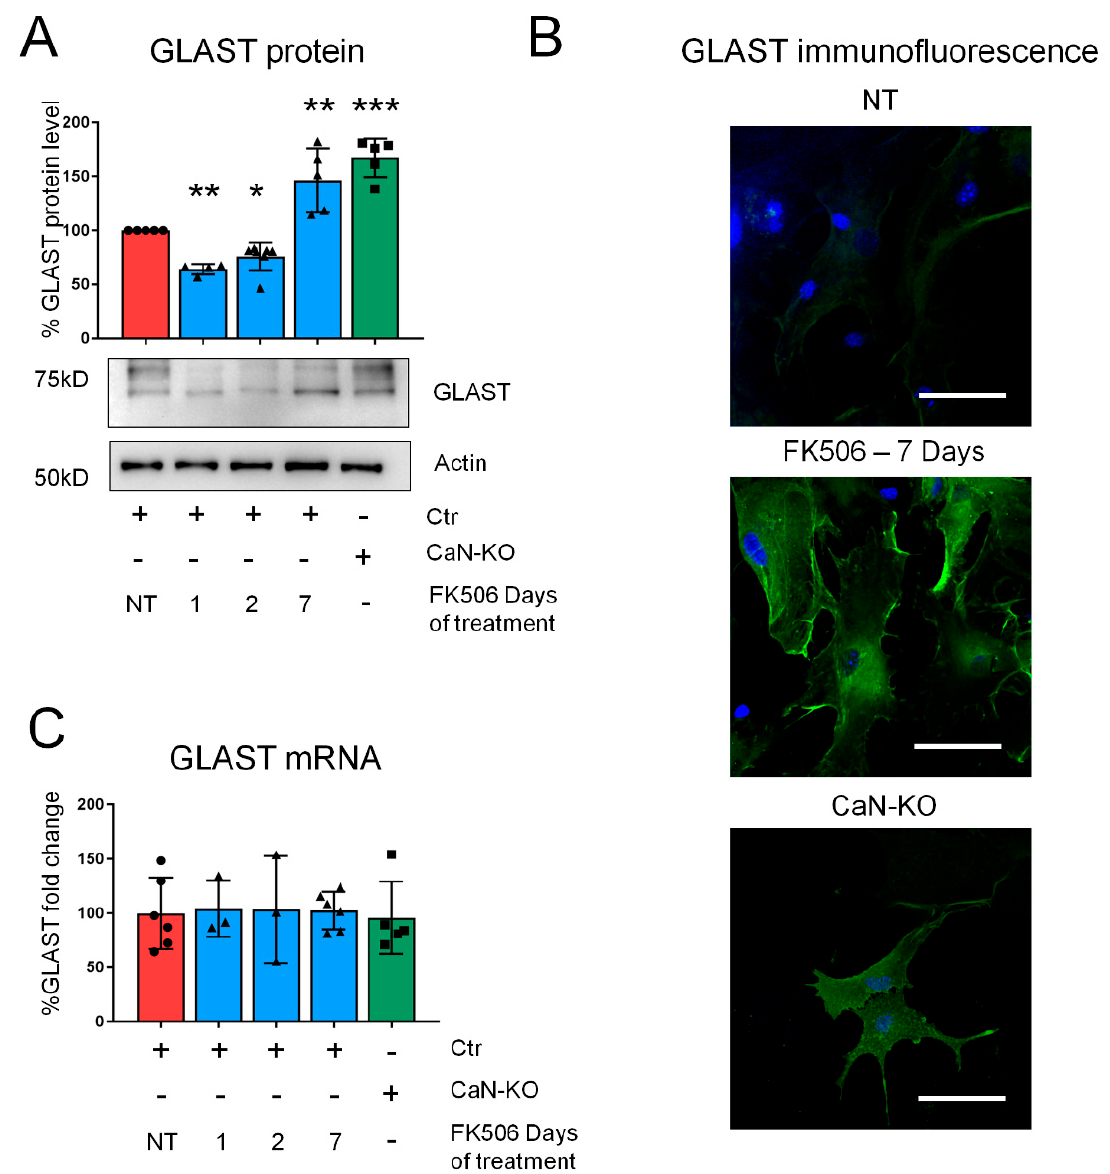
Figure 1. CaN inhibition dynamically regulates GLAST expression in mouse hippocampal astrocytes. ( A ) Glutamate/aspartate transporter (GLAST) protein expression in primary cultures of hippocampal astrocytes from control not-treated (Ctr, NT) Ctr astrocytes treated with FK506 200nM for 1, 2 and 7 days and of cultured astrocytes from mice with an astrocyte-specific deletion of Ca 2 + / calmodulin-activated phosphatase calcineurin (CaN-KO). Data are expressed as mean ± SD, 5 independent cultures were used for each condition. * p < 0.05; ** p < 0.01; *** p < 0.001, one way ANOVA with Tukey post hoc test. ( B ) Immunofluorescence anti-GLAST images of Ctr-NT, Ctr treated with FK506 200 nM for 7 days and CaN-KO. Green, GLAST; blue, DAPI (4 ′ ,6-diamidino-2-phenylindole). Bar, 50 μ m. ( C ) Real-time PCR of GLAST from primary astrocytes from Ctr-NT, Ctr treated with FK506 200 nM for 1, 2, and 7 days, and from astrocyte-specific CaN-KO mice. Values represent mean ± SD Δ C(t) of gene/S18 of 6 independent cultures for each condition.